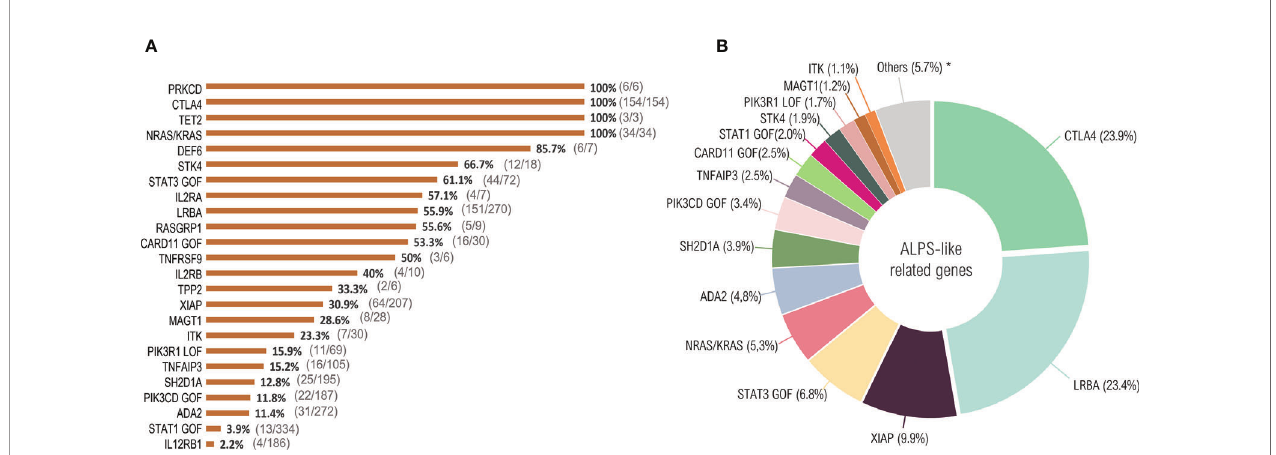
FIGURE 1 | ALPS-like related cases. Twenty-four distinct genetic defects with immune dysregulation, lymphoproliferation and autoimmunity were identi fi ed in the literature until October 2020. More than 2000 total cases were reported. After fi ltering according to the ALPS-like inclusion criteria, 645 patients were selected. (A) percentage of patients that ful fi ll clinical ALPS-like phenotype criteria. The number of ALPS-like patients with respect to the total number of patients counted in each genetic defect is indicated in parentheses. (B) ALPS-like related genes prevalence. *ALPS-like related genes with a prevalence less than 1%: PRKCD (0.9%), DEF6 (0.9%), RASGRP1 (0.8%), IL2RA (0.6%), IL2RB (0.6%), TNFRSF9 (0.5%), TET2 (0.5%), TPP2